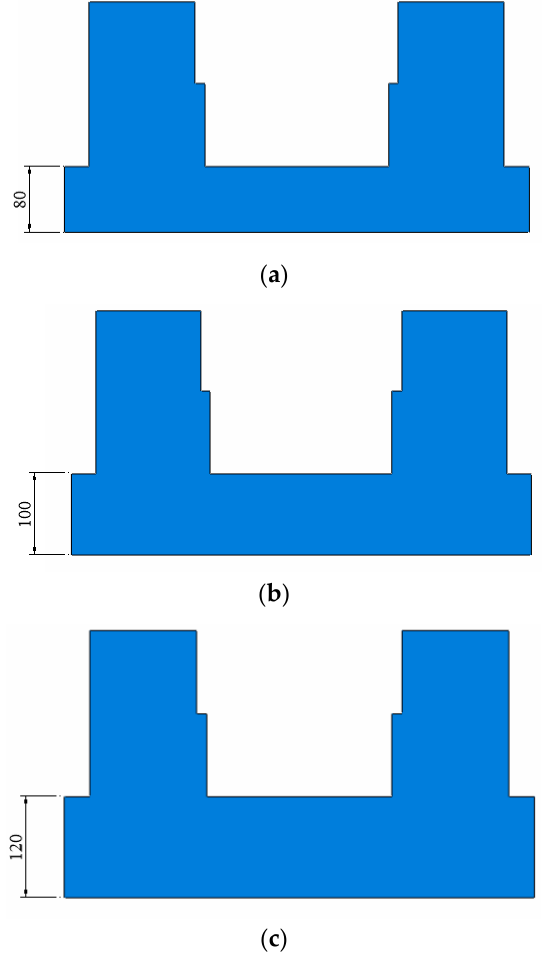
Figure 6. Schematic diagram of the structure of the lower slab of the rail seats. ( a ) 80 mm, ( b ) 100 mm, and ( c ) 120 mm.